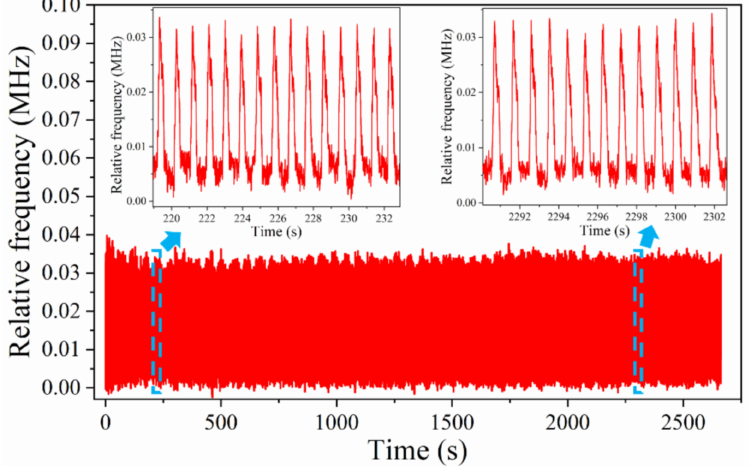
Figure 11. Repeatability of the flexible pressure